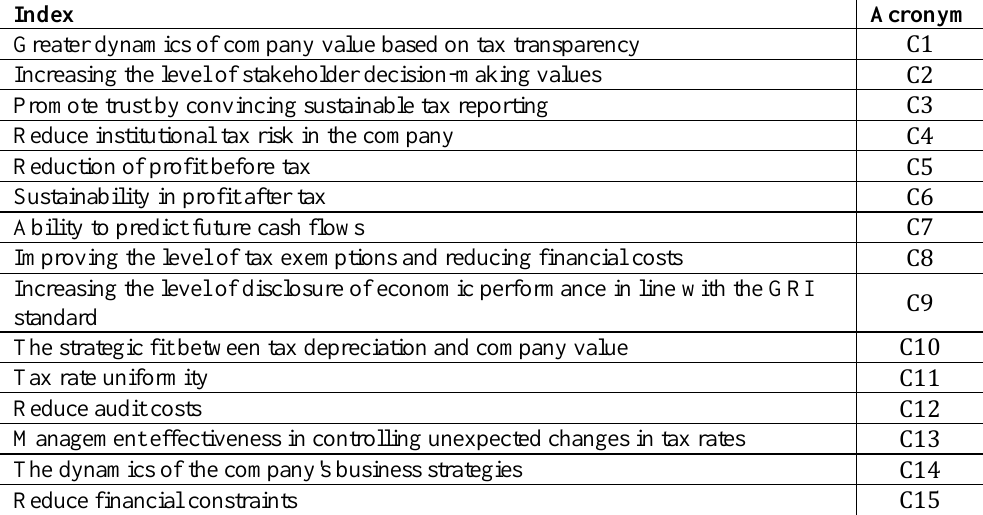
Table 8. Abbreviated coding of approved